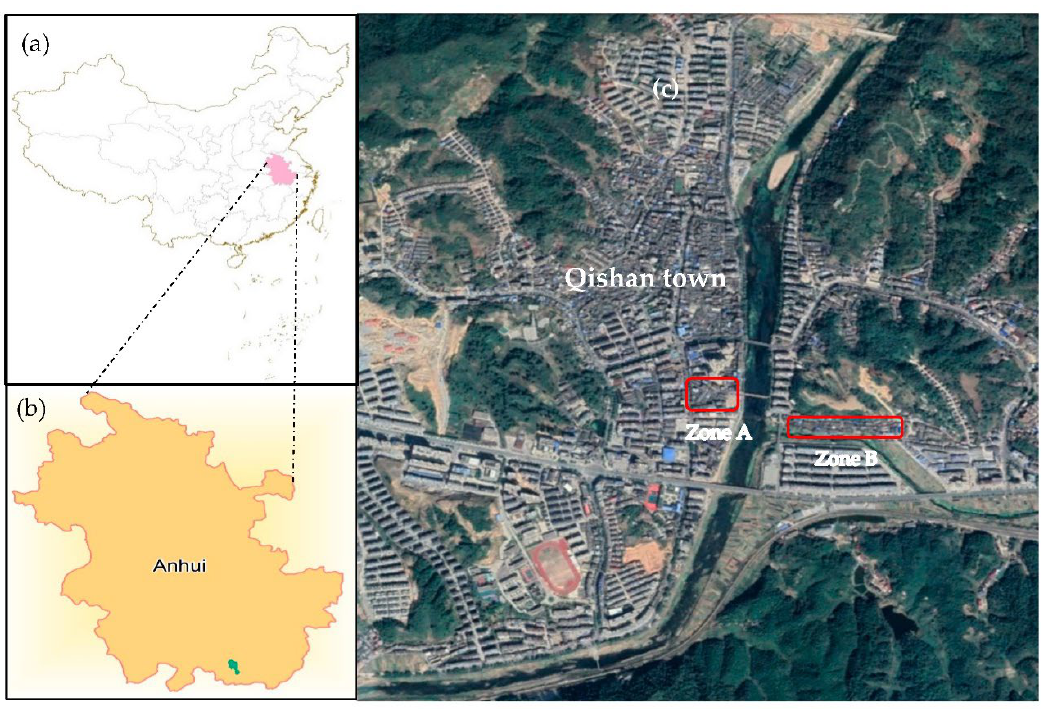
Figure 1. Study area ( a ) Anhui Province in China, ( b ) Qishan Town in Anhui Province, and ( c ) Zone A and Zone B in Qishan Town.